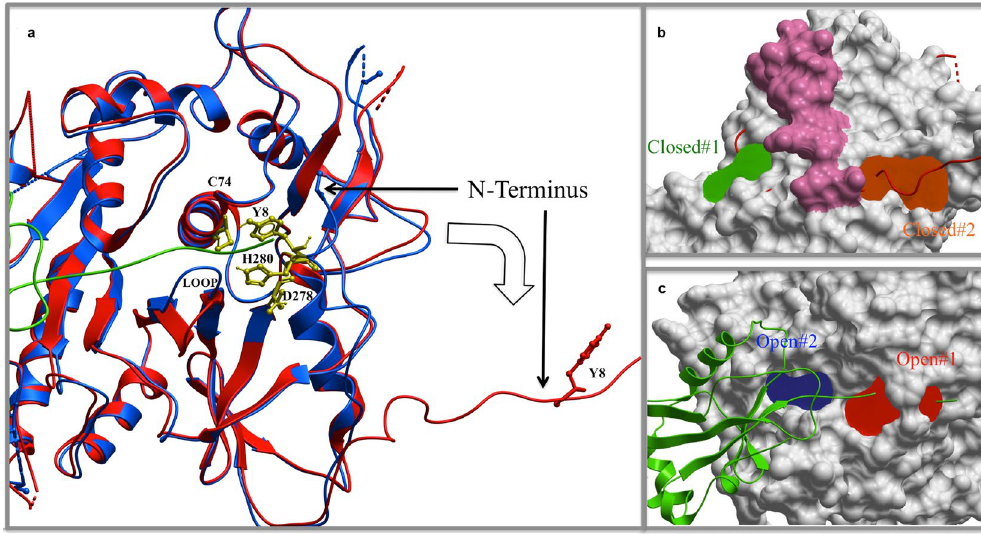
Figure 1. Binding pocket prediction in ATG4B. ( a ) Ribbon model to show the conformational changes from a free, inactive form (blue) to an active, substrate-binding form (red) of ATG4B. Key catalytic residues and the N-terminal Tyr8 are displayed and labelled. LC3B is in the green ribbon model. Two significant conformational changes occurred at the regulatory loop and the N-terminus. ( b ) Two pockets (green and orange) identified on the inactive conformation (grey skin model). The active conformation is displayed in red ribbon. The skin formed by the N-terminal of the inactive conformation is colored pink. ( c ) Two pockets (red and blue) identified on the surface of the active conformation (grey skin model). The LC3 is shown in green